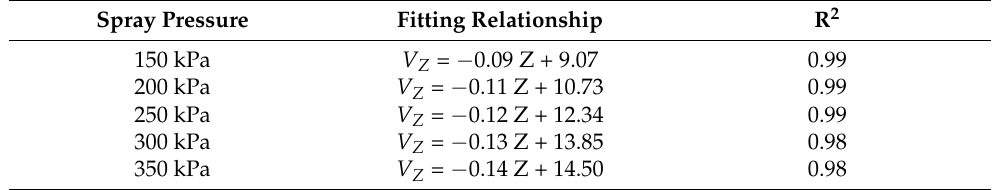
Table 5. The fitting relationship between droplet velocity V Z and vertical distance Z at spray pressure.